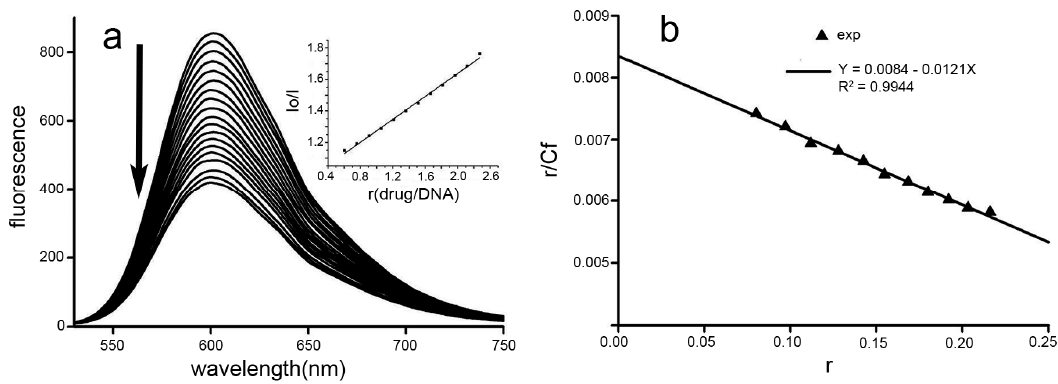
Figure 9. Fluorescence quenching spectra of EB-Ct-DNA by Dp44mT. ( a ) Fluorescence decreased with increasing Dp44mT, the insert showing that the I 0 /I increased with concentration of Dp44mT; and ( b ) Scatchard plot used to determine the association constant K EB as described [38]. Down arrow: trend of fluorescence decreased.